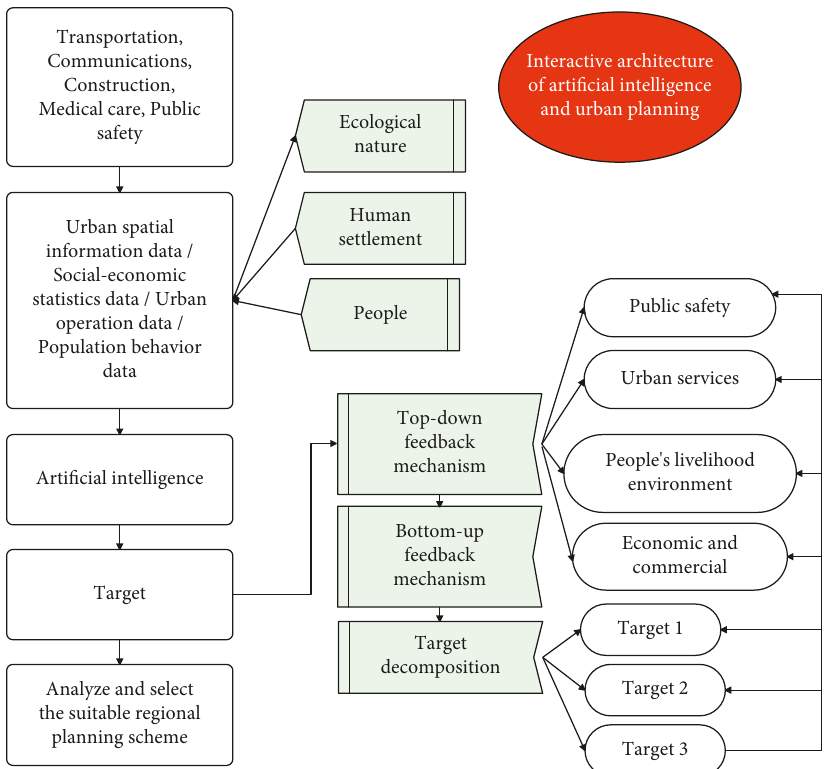
Figure 5: Complementary architecture of artificial intelligence and urban planning.